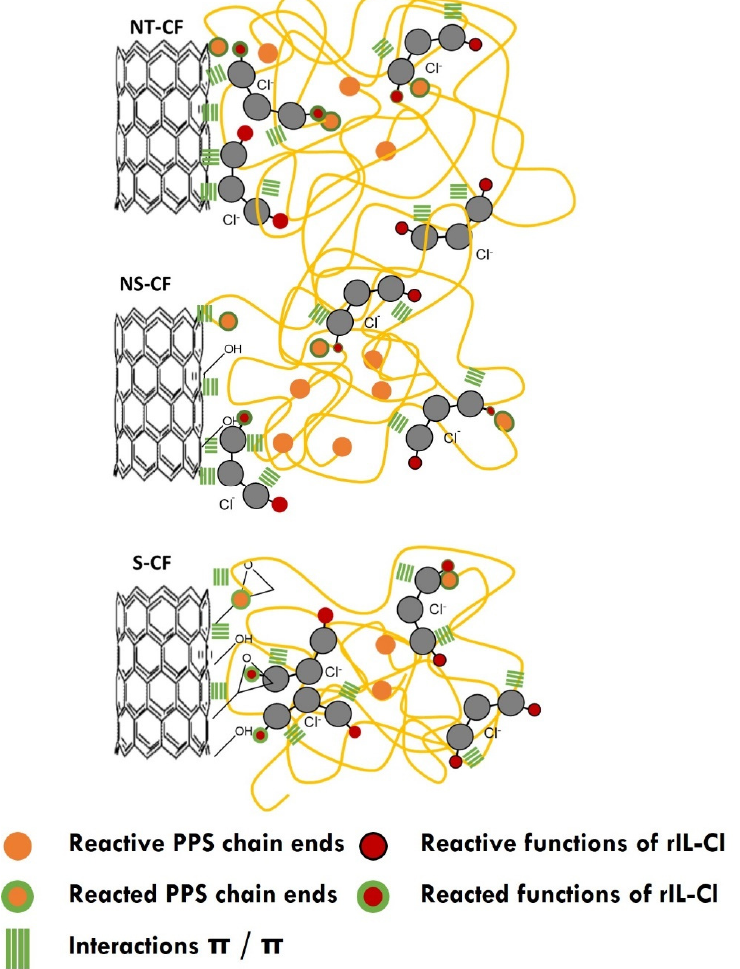
Figure 10. Schema of interactions for the interfaces between Imidazolium modified PPS and NT-CF, NS-CF and S-CF. NS-CF and